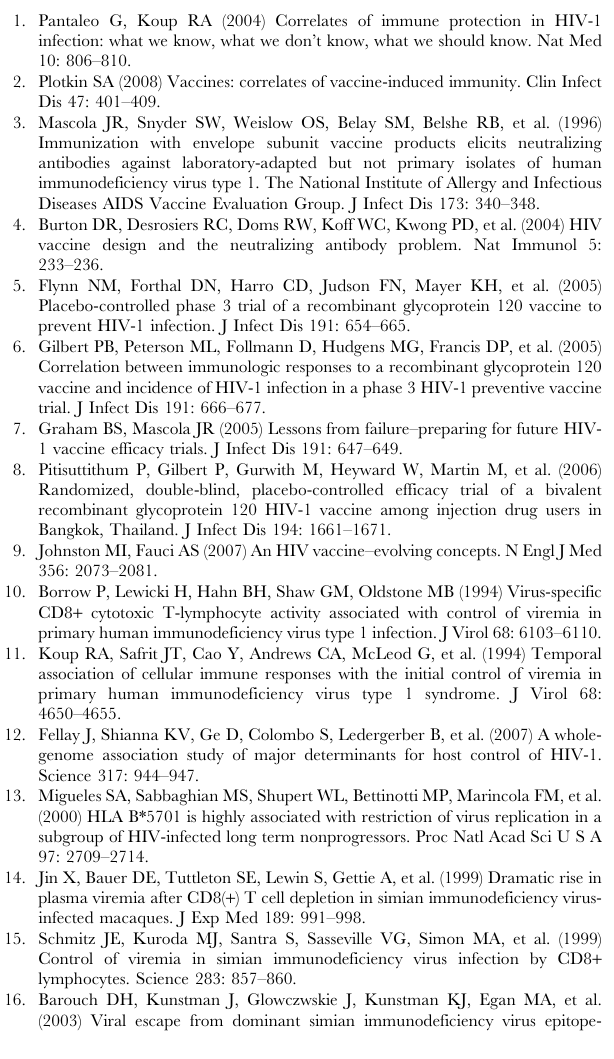
Figure S2 Envelope-specific ELISA antibody responses in subjects 4 weeks after the third dose of DNA or after a single dose of rAd5 vaccine only compared to peak response at 4–6 weeks following rAd5 vector boosting. Data for the rAd5 vaccine only group comes from protocol VRC 006 (18). Bars represent medians and one standard